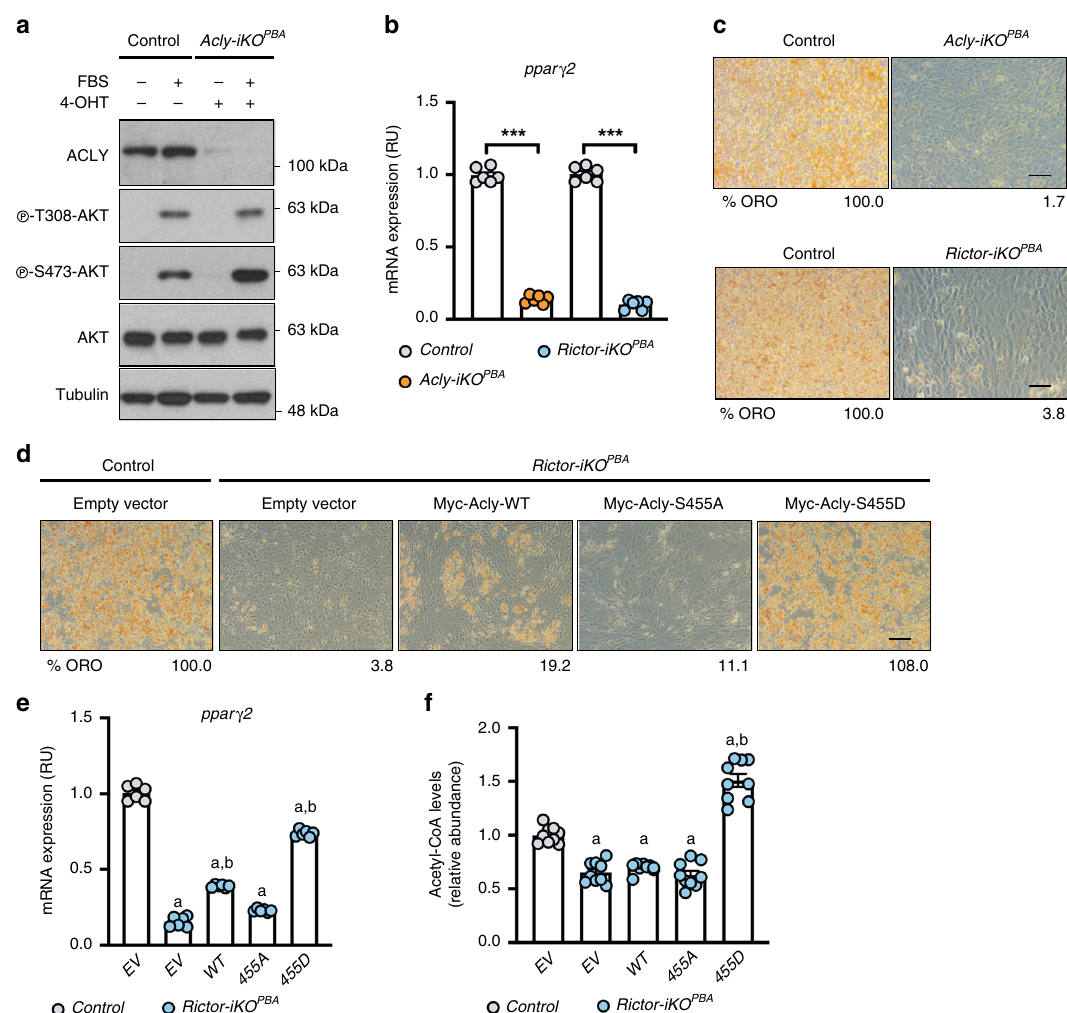
Fig. 3 ACLY is the critical mTORC2 effector during brown adipocyte differentiation. a Western blot showing ablation of ACLY protein and AKT phosphorylation upon brief 4-OHT treatment of Acly-iKO PBA cells. b , c Acly-iKO PBA and Rictor-iKO PBA cells were differentiated and ppar γ 2 mRNA expression ( n = 6 per group) ( b ) and Oil Red O (ORO) staining of lipids ( c ) were quanti fi ed at day 10 to determine differentiation ef fi ciency. Scale bar represents 50 μ m. d , e Representative differentiation rescue experiments showing ORO staining ( d ) and Ppar γ 2 mRNA expression ( n = 6 per group) ( e ) in Rictor-iKO PBA cells stably expressing empty (EV), Myc-ACLY-WT, Myc-ACLY-S455A, or Myc-ACLY-455D constructs. Percentage of ORO in d is relative to empty vector control. Scale bar represents 50 μ m. f Direct acetyl-CoA measurements of Rictor-iKO PBA cells ( n = 9 per group) stably expressing empty (EV), Myc- ACLY-WT, Myc-ACLY-S455A, or Myc-ACLY-455D constructs. Bar graphs represent mean ± SEM. *** p < 0.001. a represents *** p < 0.001 vs control (EV), and b represents *** p < 0.001 vs Rictor-iKO PBA (EV). Statistical signi fi cance was calculated by using two-way ANOVA with Sidak ’ s test multiple comparisons ( b , e , f